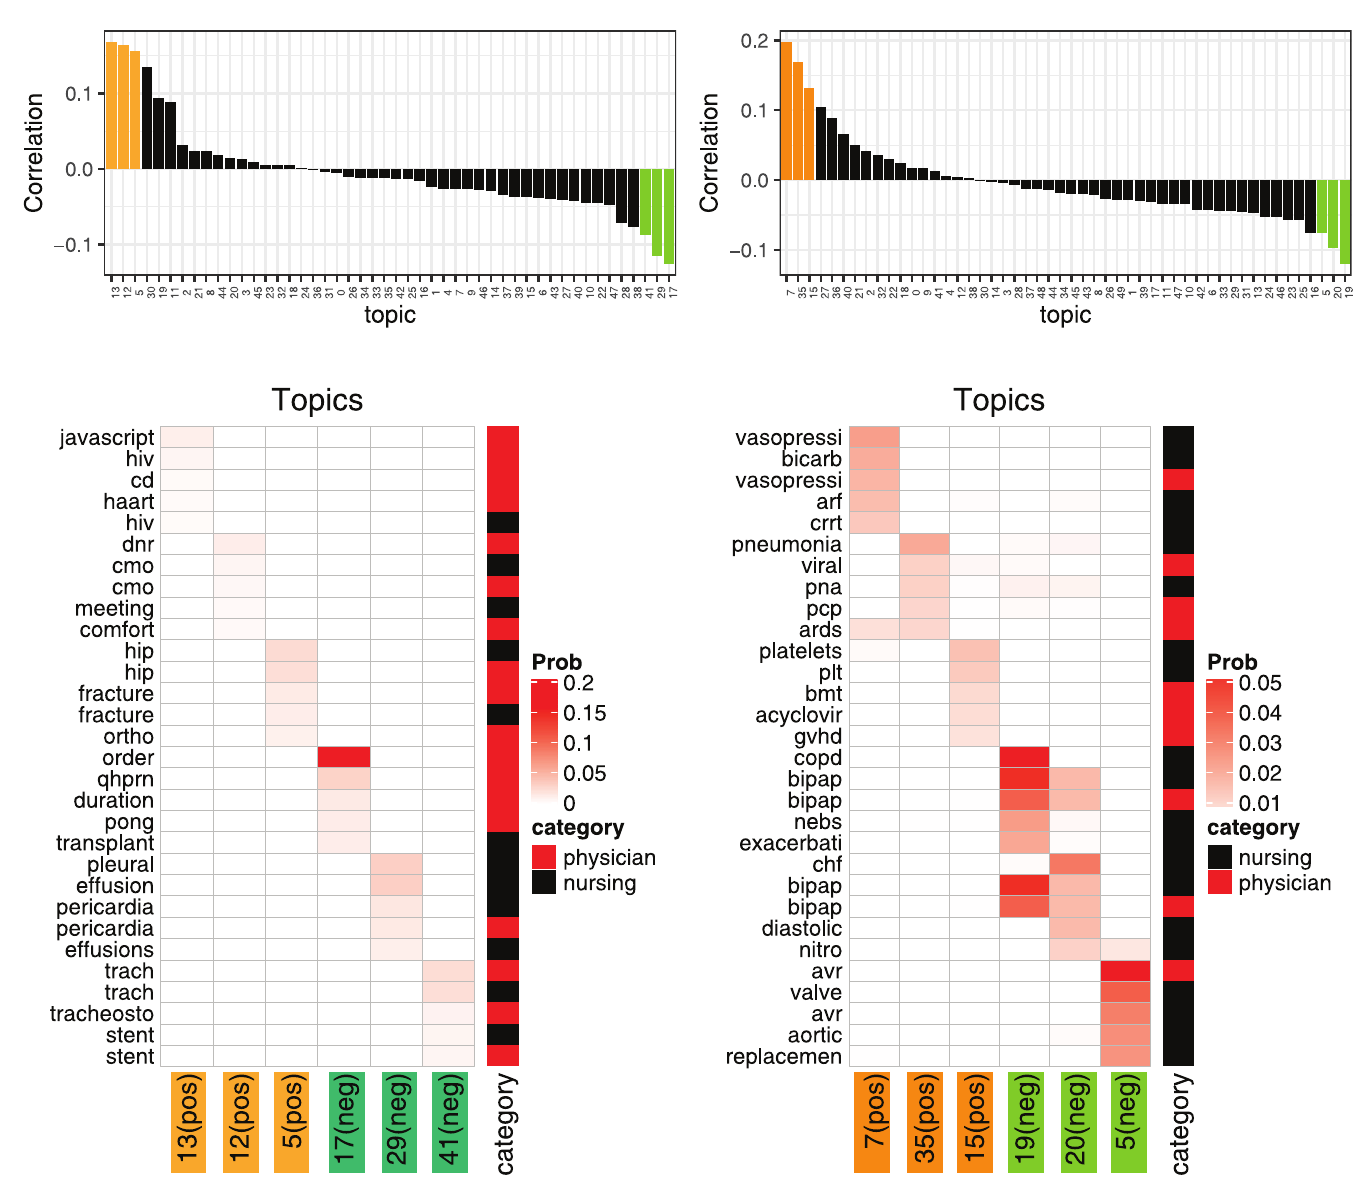
Fig 5. Topic correlations with the MV duration. We correlated the topic mixture with the MV duration and displayed the correlation as barplots We then visualize the top words for the the topics that are most positively and negatively correlated with PMV using (a) the single-note model; (b) the multi-note model. Only the 3 most positively and the 3 most negative correlated topics were shown for each